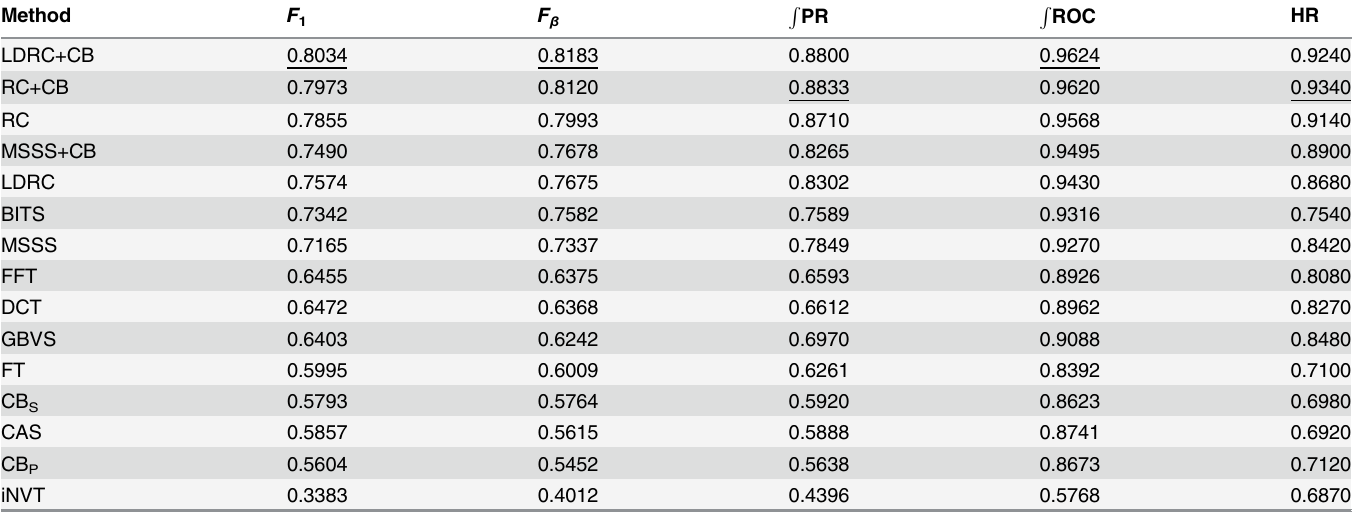
Table 2. The maximum F 1 score, maximum F β score, PR AUC ( ascending by F β ).